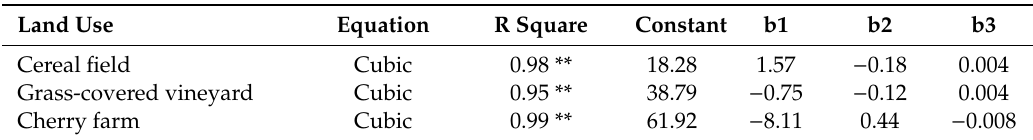
Table 4. Regression coe ffi cient for determining the relationship between the microbial respiration rates in di ff erent land use after an incubation period of 25 days.